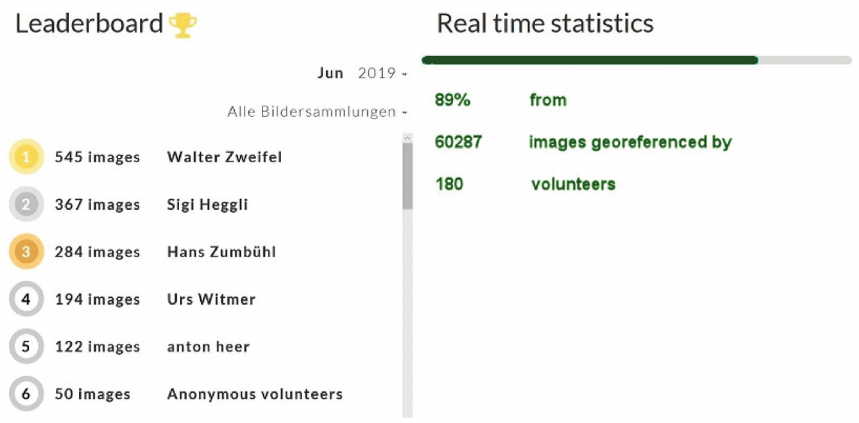
Fig. 1: Boosting friendly competition by publishing statistics (Screenshot from sMapshot, retrieved June 15, 2019, from